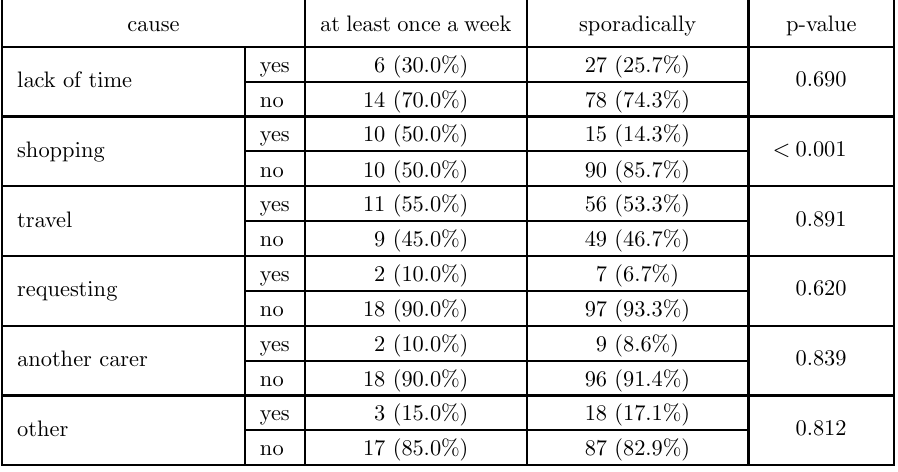
Table 3. Situations conductive to fast-food consumption by children